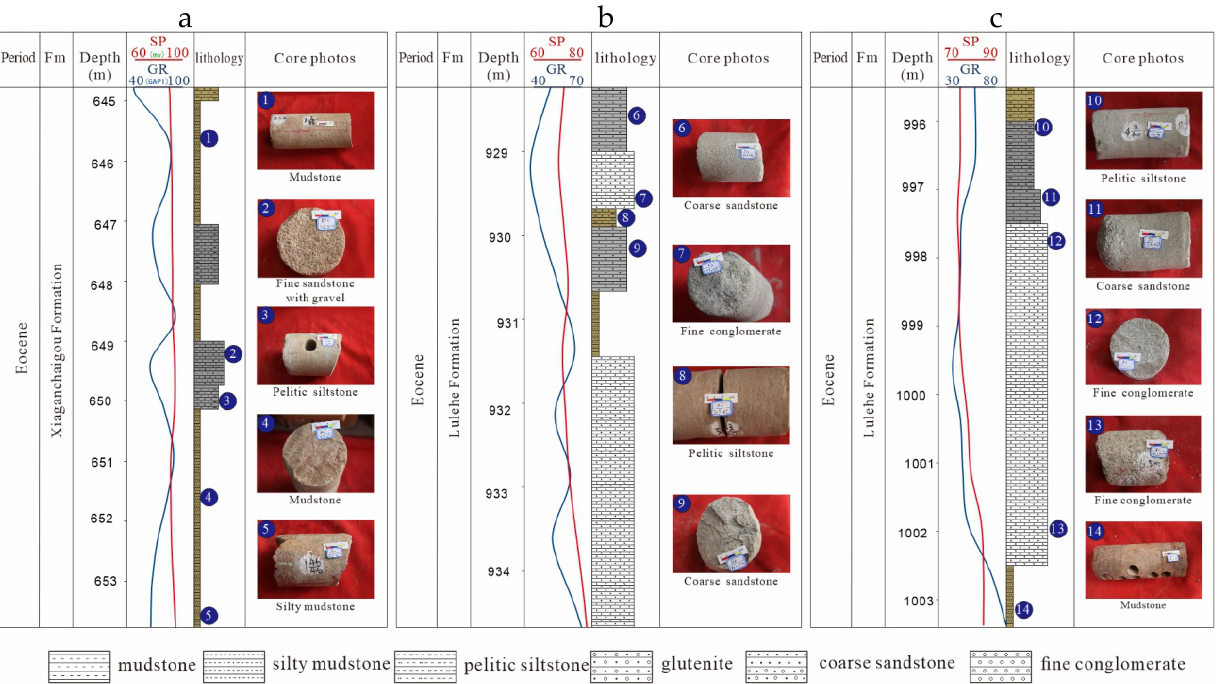
Figure 2. Core and logging characteristics of the coring section of Well Ping 2. ( a ) 9.00 m of core was obtained from between 644.77 m and 653.77 m; ( b ) 3.33 m of core was obtained from between 928.23 m and 934.81 m; ( c ) 8.00 m of core was obtained from between 995.50 m and 1003.50 m.